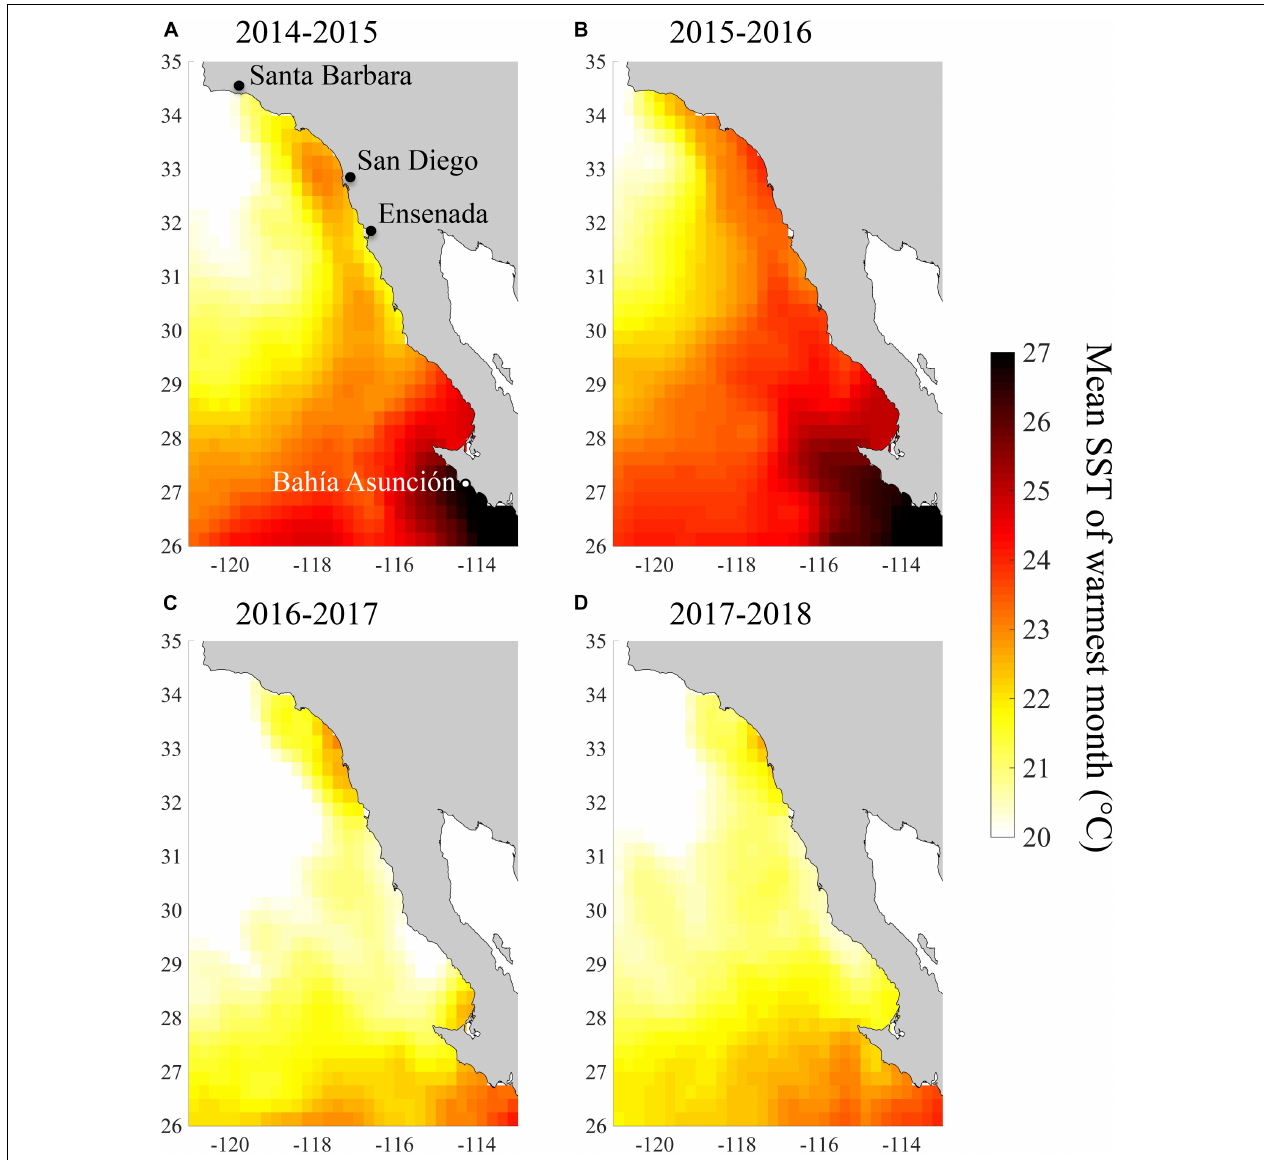
FIGURE 4 | Mean SST of the warmest month across the study region for (A) July 2014–June 2015, (B) July 2015–June 2016, (C) July 2016–June 2017, and (D) July 2017–June